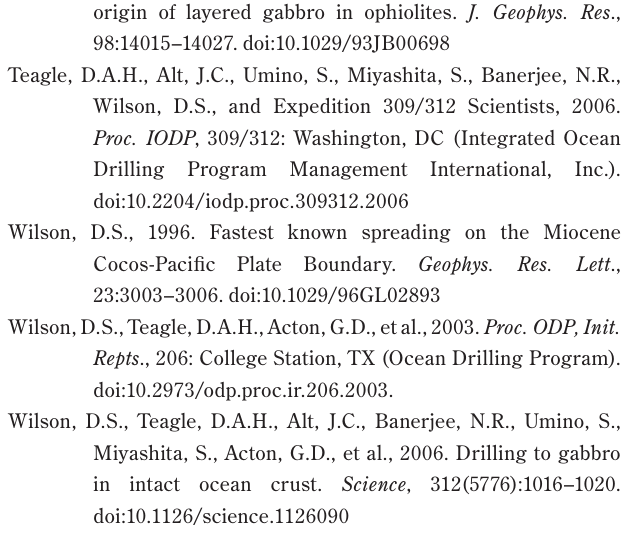
Fig. 6: Photos [A] to [D], and [F]: Benoit Ildefonse, CNRS; Photo [E]: Johan Lissenberg, Cardiff